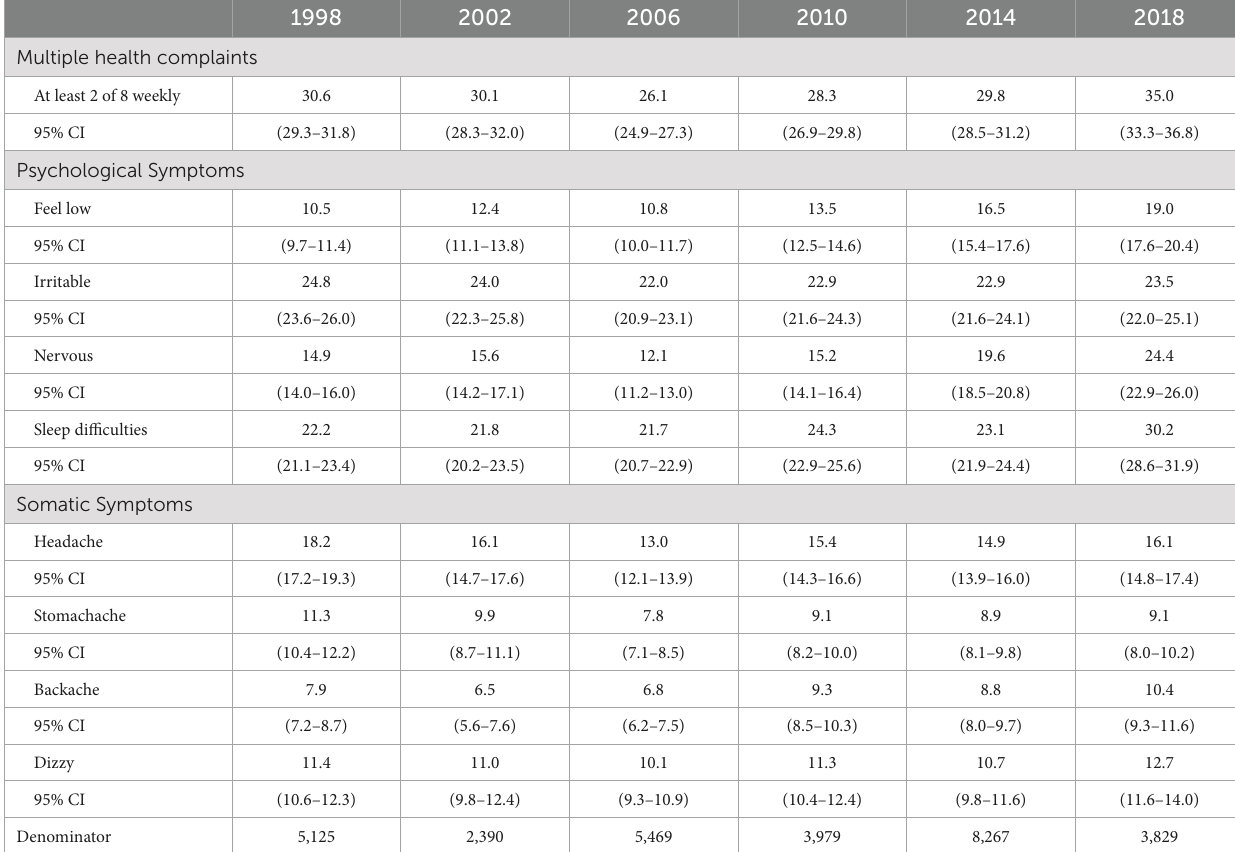
TABLE 1 Percentages of multiple health complaints, somatic symptoms, and psychological symptoms, by survey